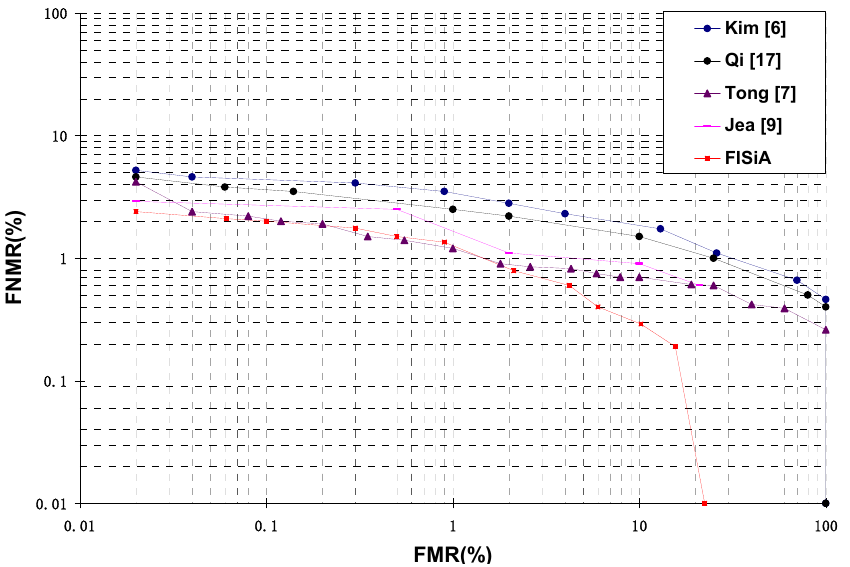
Figure 14. ROC curves of FISiA and other related methods on FVC2002